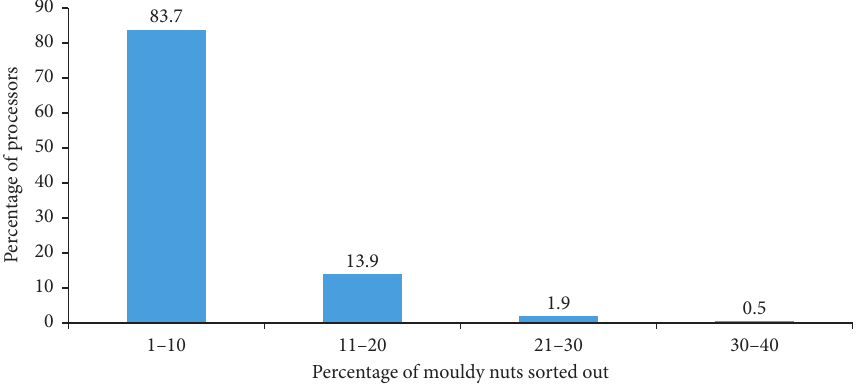
Figure 9: Percentage of mouldy nuts identified during sorting by